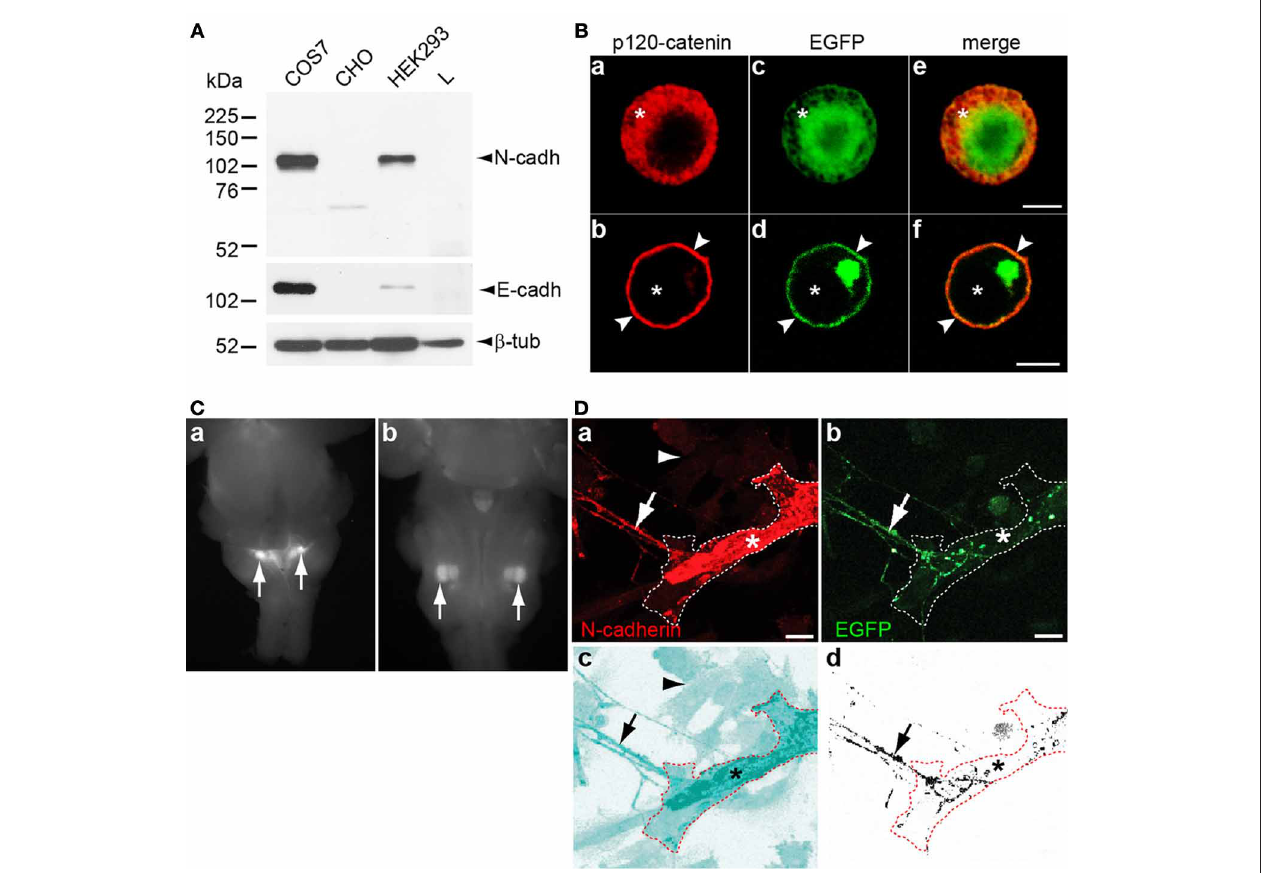
FIGURE 1 | (A) Cultured COS-7, CHO, HEK293, and L cells were lysed and analyzed by Western blot with antibodies against N-cadherin, E-cadherin, and β -tubulin. N-cadherin was detected in COS-7 and HEK293 cells, while E-cadherin detected in COS-7 cells and at very low levels in HEK293 cells. CHO and L cells were devoid of both cadherins. (B) CHO cells transfected with EGFP ( a , c , and e ) or with N-cadherin-EGFP ( b , d , and f ) were fixed 48h after transfection and immunolabeled with anti p120-catenin antibodies and Cy3-conjugated secondary antibodies (red). In EGFP transfected cells, p120-catenin was localized to the cytosol (asterisks) while expression of N-cadherin shifted the subcellular localization of p120-catenin to the cell membrane (arrowheads in b , d , and f ). (C) Dorsal (a) and ventral (b) views of E16 ChAT BAC EGFP mouse brainstem showing EGFP expressing nuclei in the dorsomedial region (a) and in the ventrolateral quadrant (b) corresponding to the localization of preganglionic parasympathetic neurons [ (a) arrows], and of the facial motor nucleus [ (b) arrows], respectively. (D) N-cadherin transfected